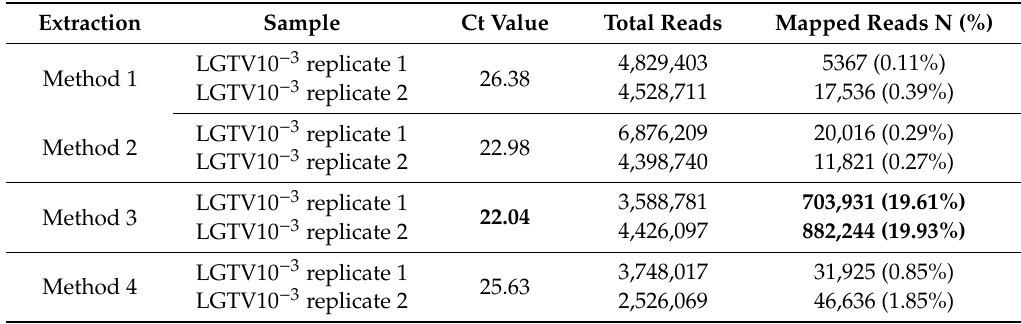
Table 3. Recovered viral reads by mNGS analysis based on initial assessment of di ff erent extraction methods (Method 1, 2, 3, and 4) for metagenomic identification of viral vector-borne pathogens. Ct: cycle threshold. The best result is indicated in